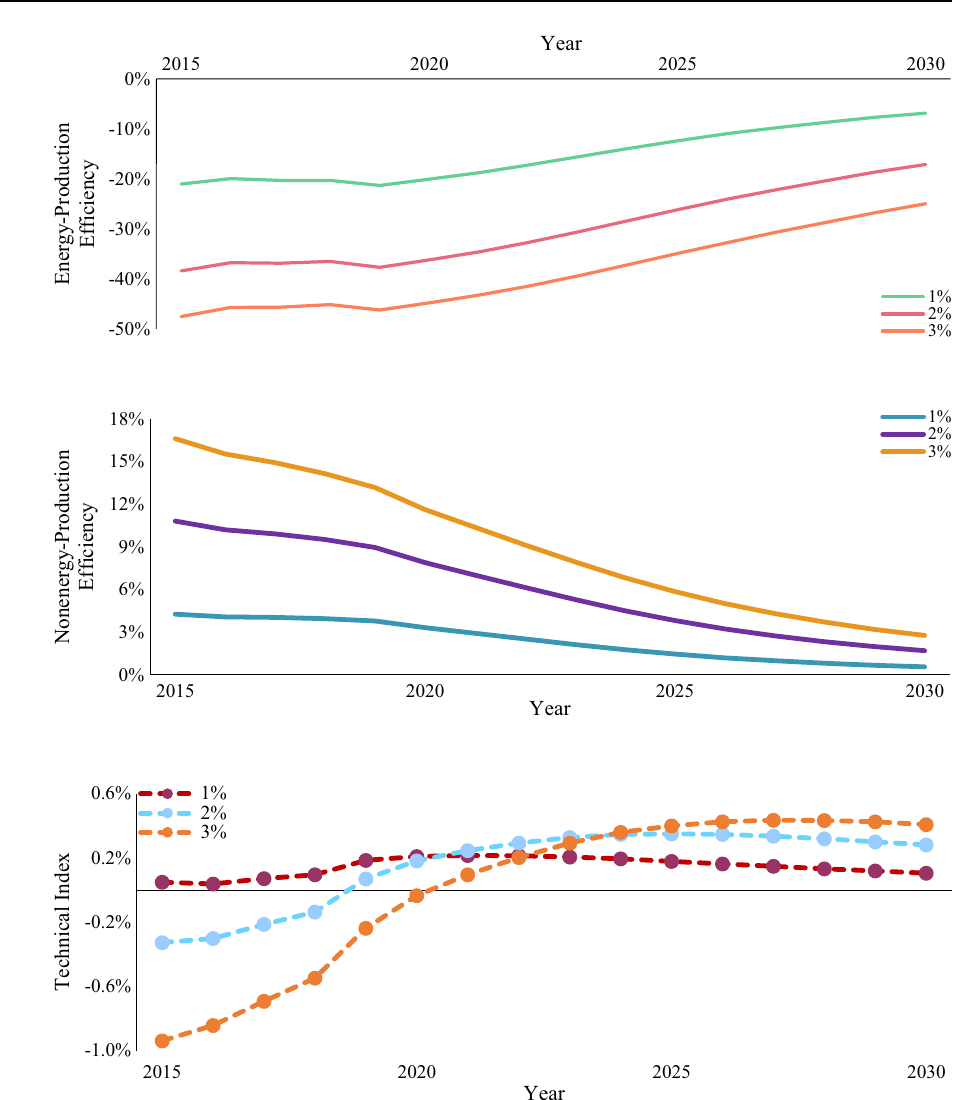
Fig. 5 The ITC impact on the technical